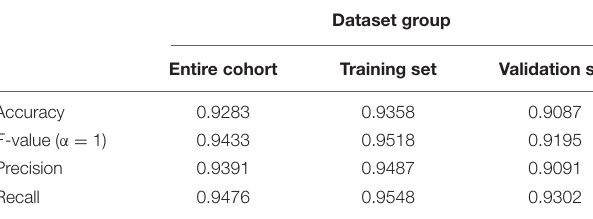
TABLE 2 | Accuracy, F -value, precision, and recall of each